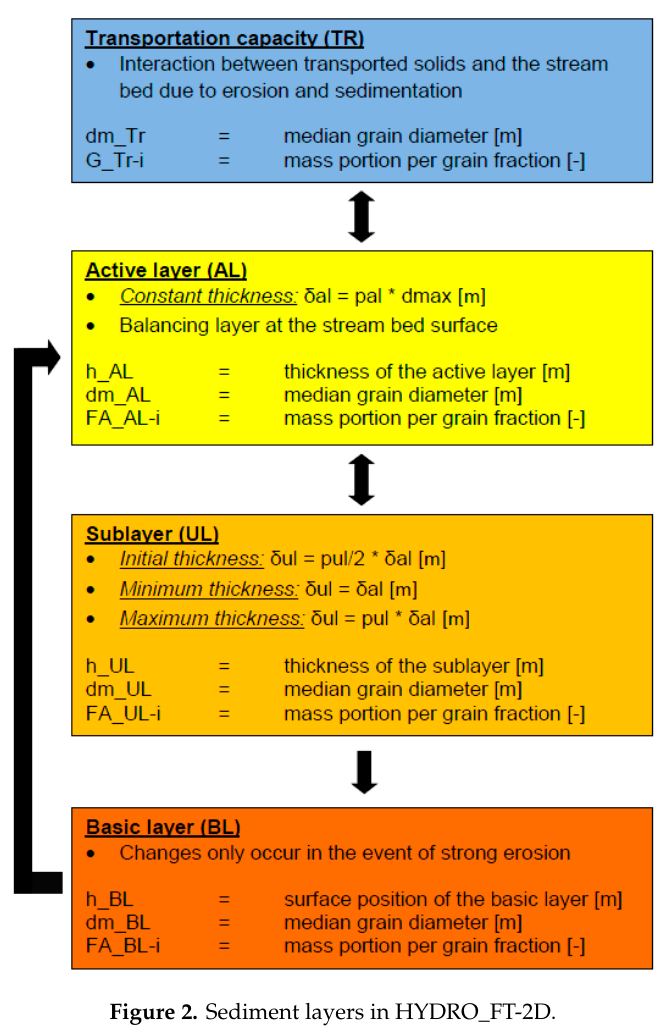
Figure 2. Sediment layers in HYDRO_FT-2D.